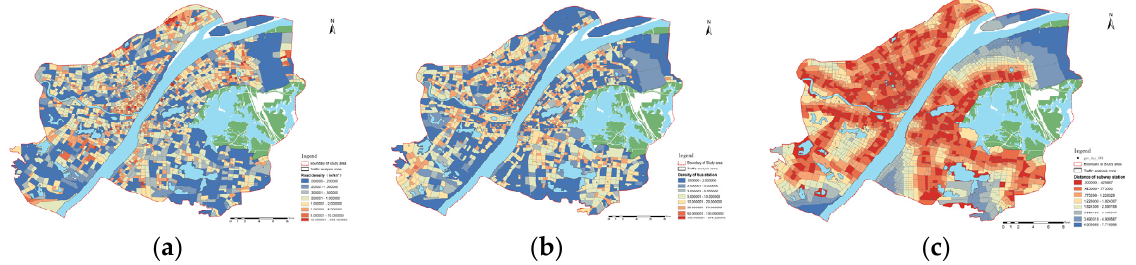
Figure 10. Neighborhood accessibility. ( a ) Road network density; ( b ) bus station density; ( c ) distance to the nearest subway station.